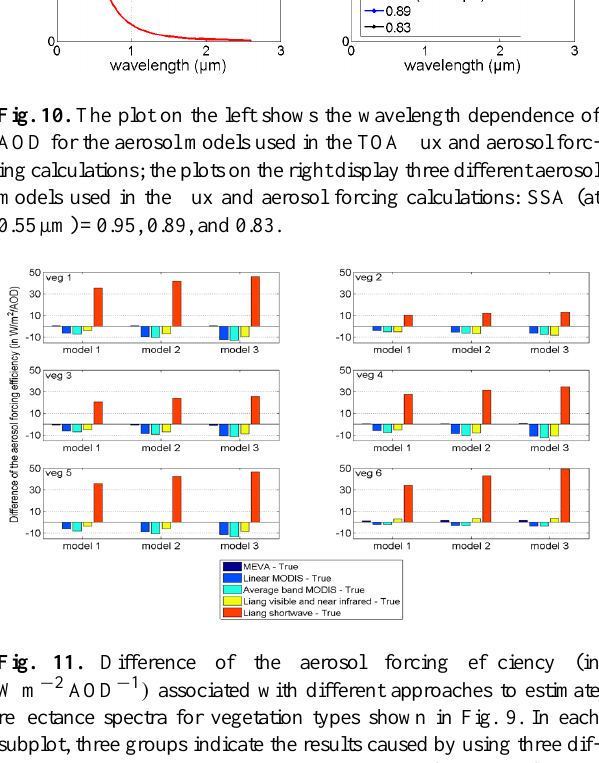
Fig. 13. Aerosol forcing when SZA varies from 0 to 90 degrees for vegetation types shown in Fig. 9. Curves in different symbols are associated with different approaches to estimate vegetation re- flectance spectrum used in the aerosol forcing calculation. Other parameters used in the calculations include AOD (at 0.55µm) of 0.32 and SSA (at 0.55µm) of